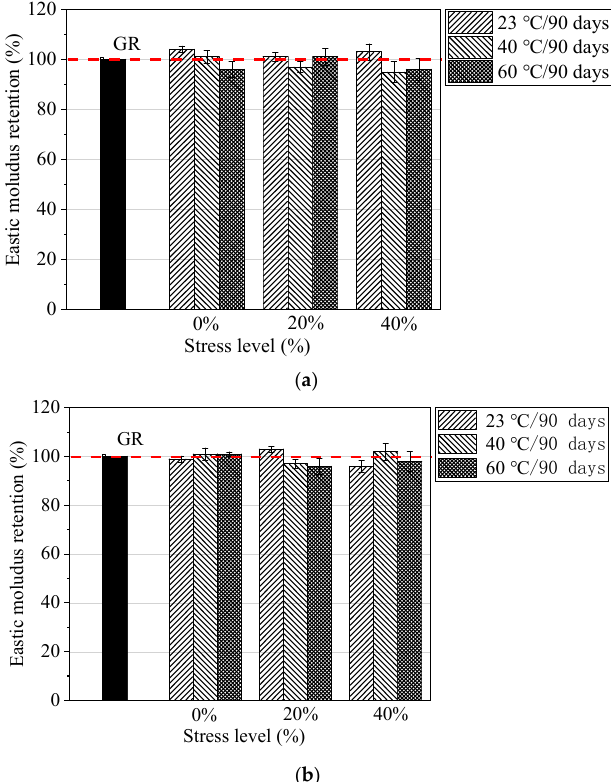
Figure 7. Elastic modulus retention of conditioned GFRP bars: ( a ) Exposure to seawater solutions and ( b ) exposure to concrete pore solutions.